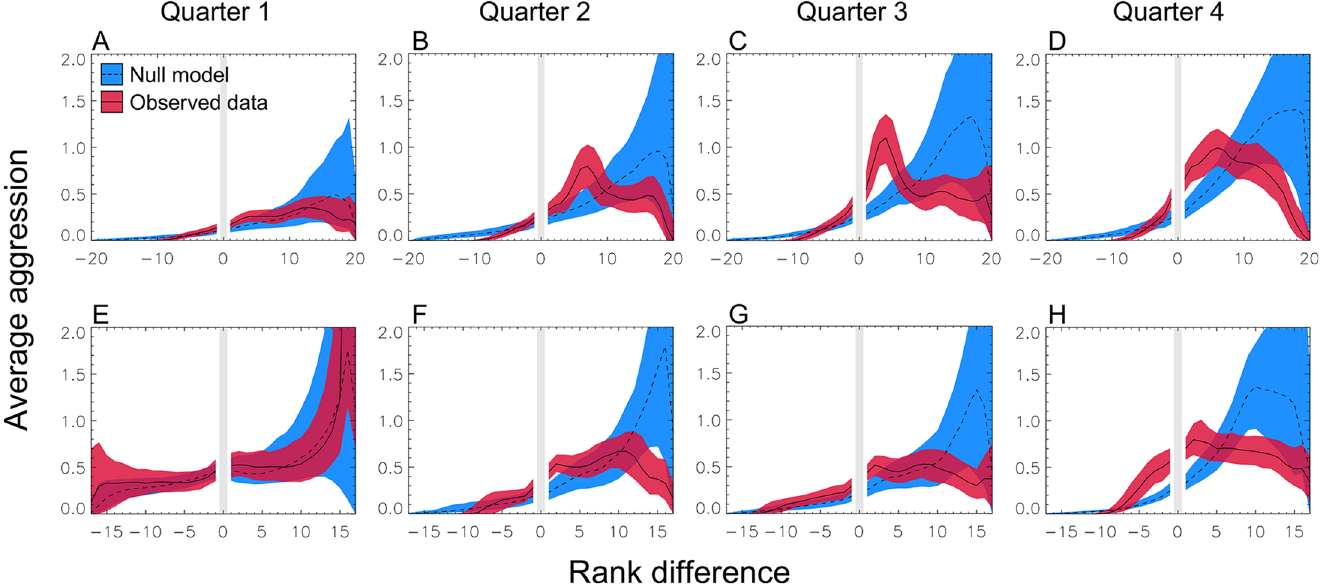
Fig 2. The emergence of structured aggression. Average rank aggression ( R ( Δ ), Eq 3) for Group One (a-d) and Group Two (e-h) across study quarters; each quarter is six days long. Units of y -axis are aggressive acts per individual per 1000 minutes (100 scan periods). Patterns of aggression (red band/solid line) in both groups are consistent with the null (dashed line/blue band) in the first Quarter, but diverge in Quarters two, three and four as individuals focus their aggression on those nearby in rank. Points are averaged ± 1 rank; bands are 1 σ bootstrap-estimated error ranges. Maximum rank difference in Group Two ( N = 19) is 17 because one individual was